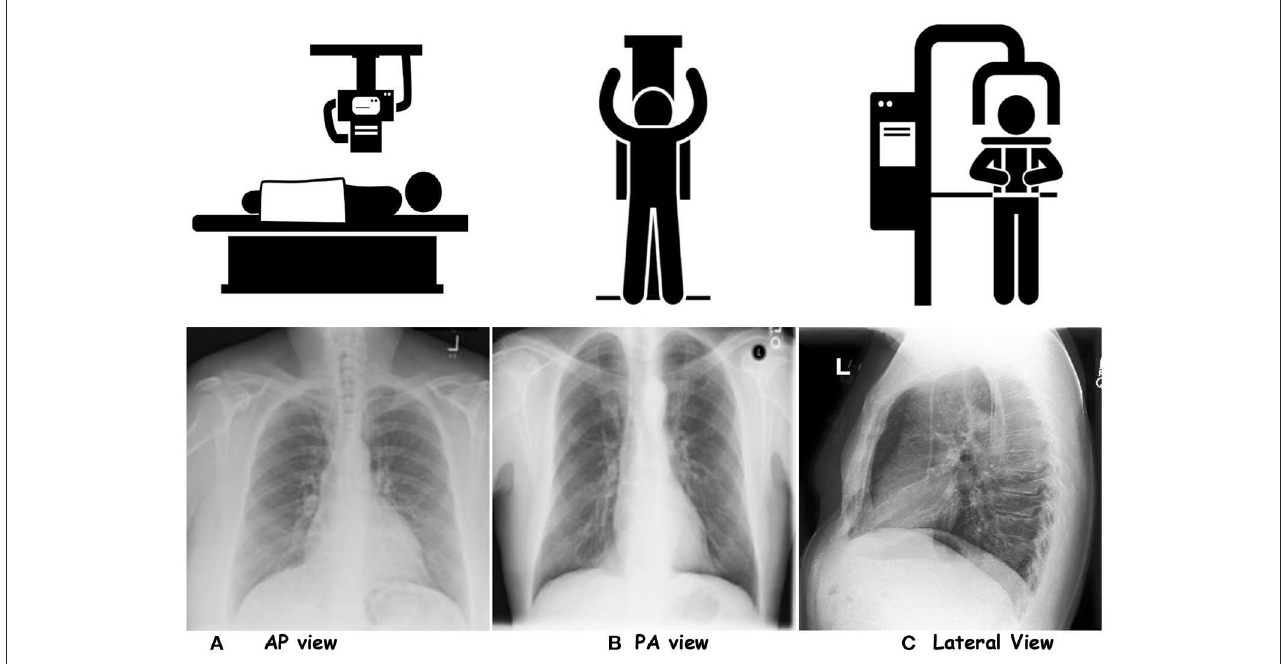
FIGURE1 Showcasing the chest-X rays for three projections. (A) AP view, (B) PA view, and (C) Lateral